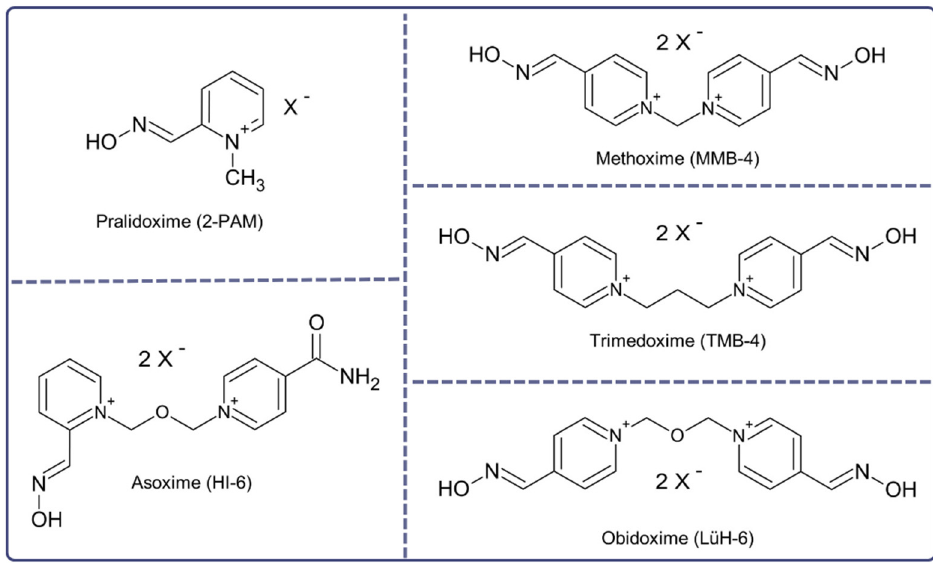
Figure 4. Chemical structures of oxime reactivators as an antidote against poisoning caused by nerve agents